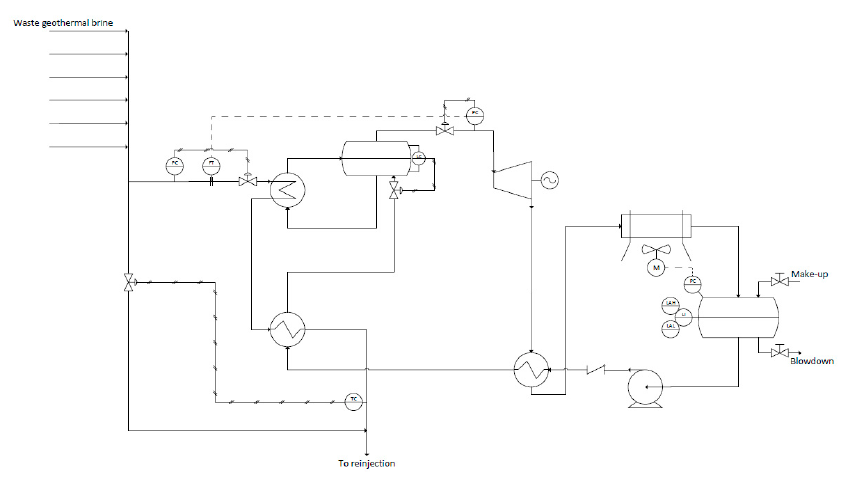
Figure 7. Process scheme of the proposed solution for energy recovery (case study 1b, Piancastagnaio).